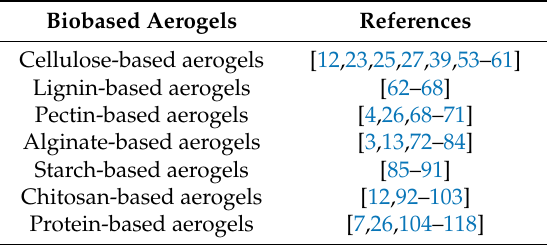
Table 1. Biobased